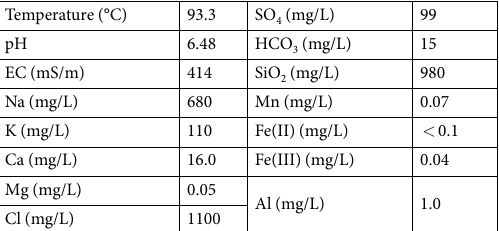
Table 3. Chemical composition of groundwater sampled in Sumikawa Geothermal Power Plant,